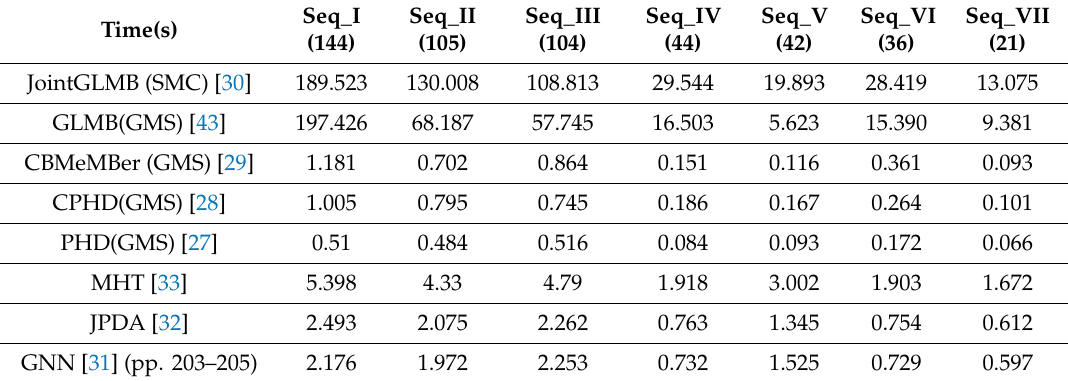
Table 1. GEO debris tracking processing time-consuming by di ff erent